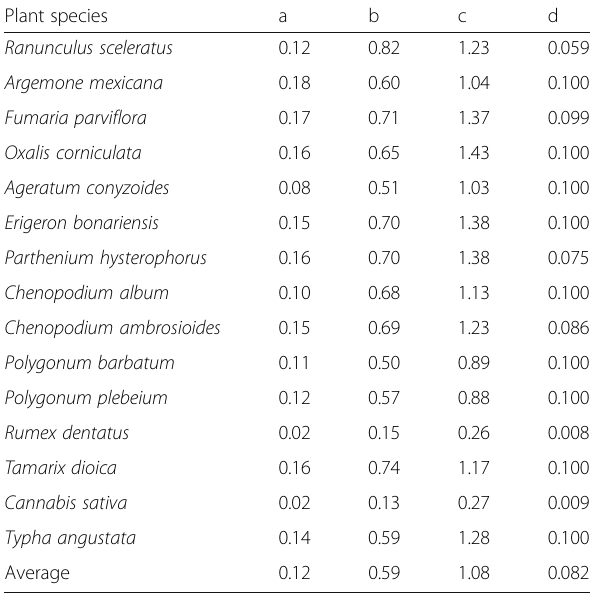
Table 4 Rate transfer coefficients of the difference equation for different organic acids